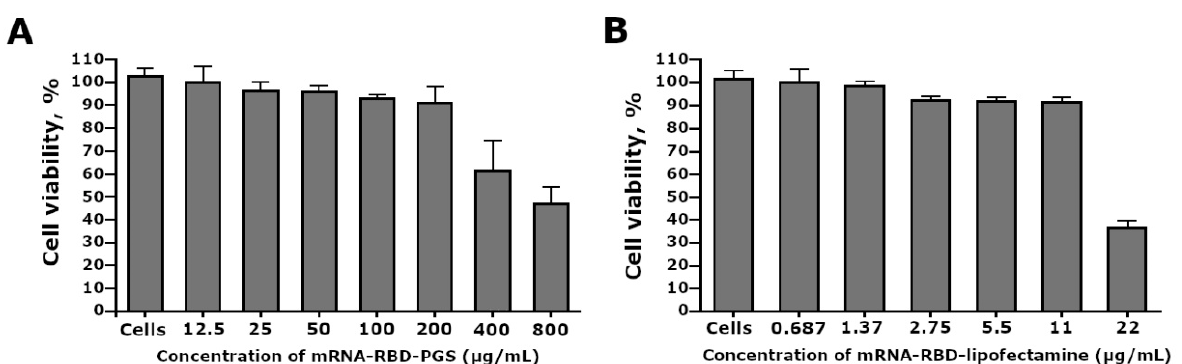
Figure 2. Estimation of HEK293 cell viability treated with mRNA-RBD-PGS ( A ) and mRNA-RBD-Lipofectamine 3000 ( B ) by MTT assay. The results are expressed as means ± SD of triplicate experiments.